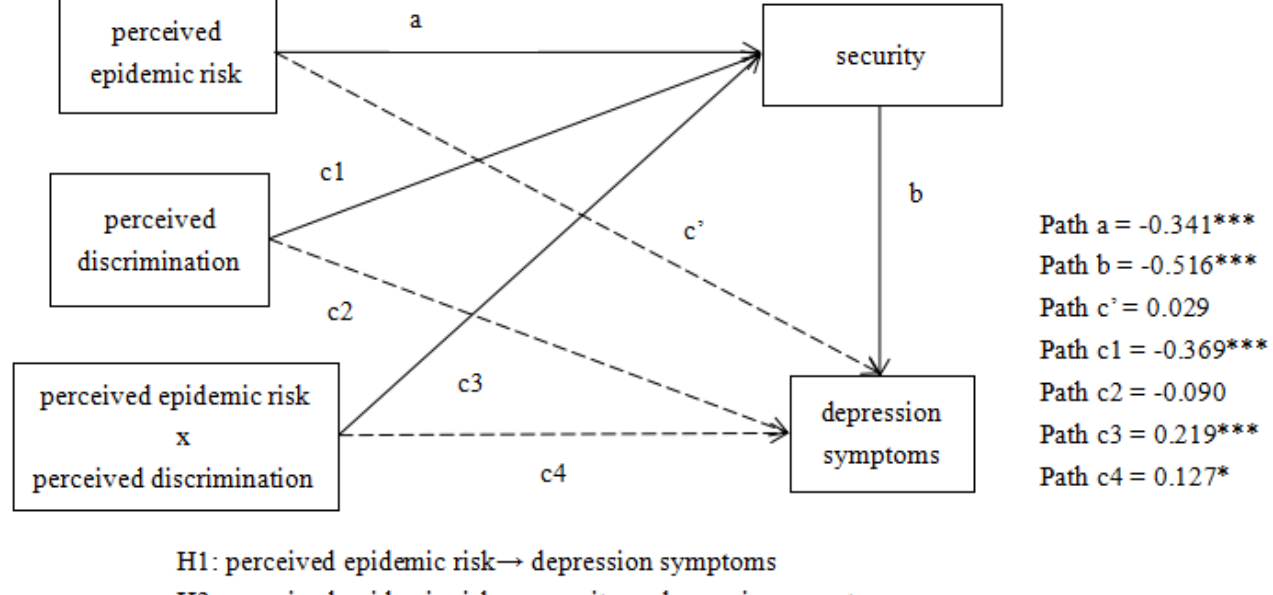
Figure 2. N = 3443; p > 0.05, * p < 0.05, *** p < 0.001; In this model, the indent effect of perceived epidemic risk on depression symptoms through security and the direct effect of perceived epidemic risk on security are supposed to be moderated by perceived